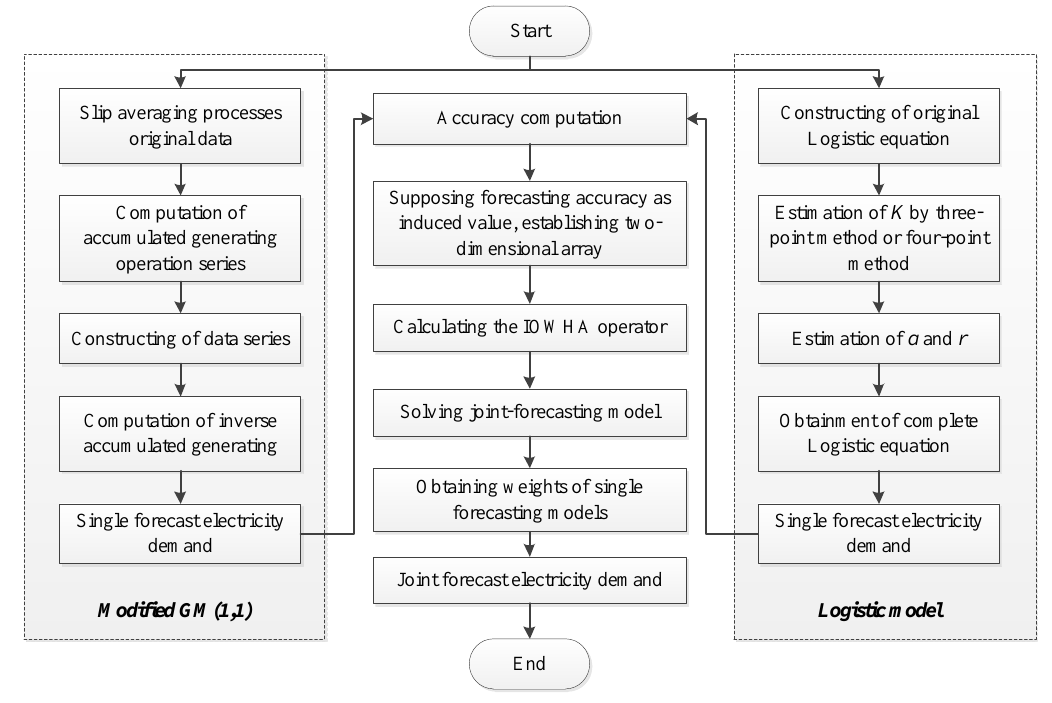
Figure 2. The flowchart of IOWHA operator-based joint-forecasting modeling of electricity demand.